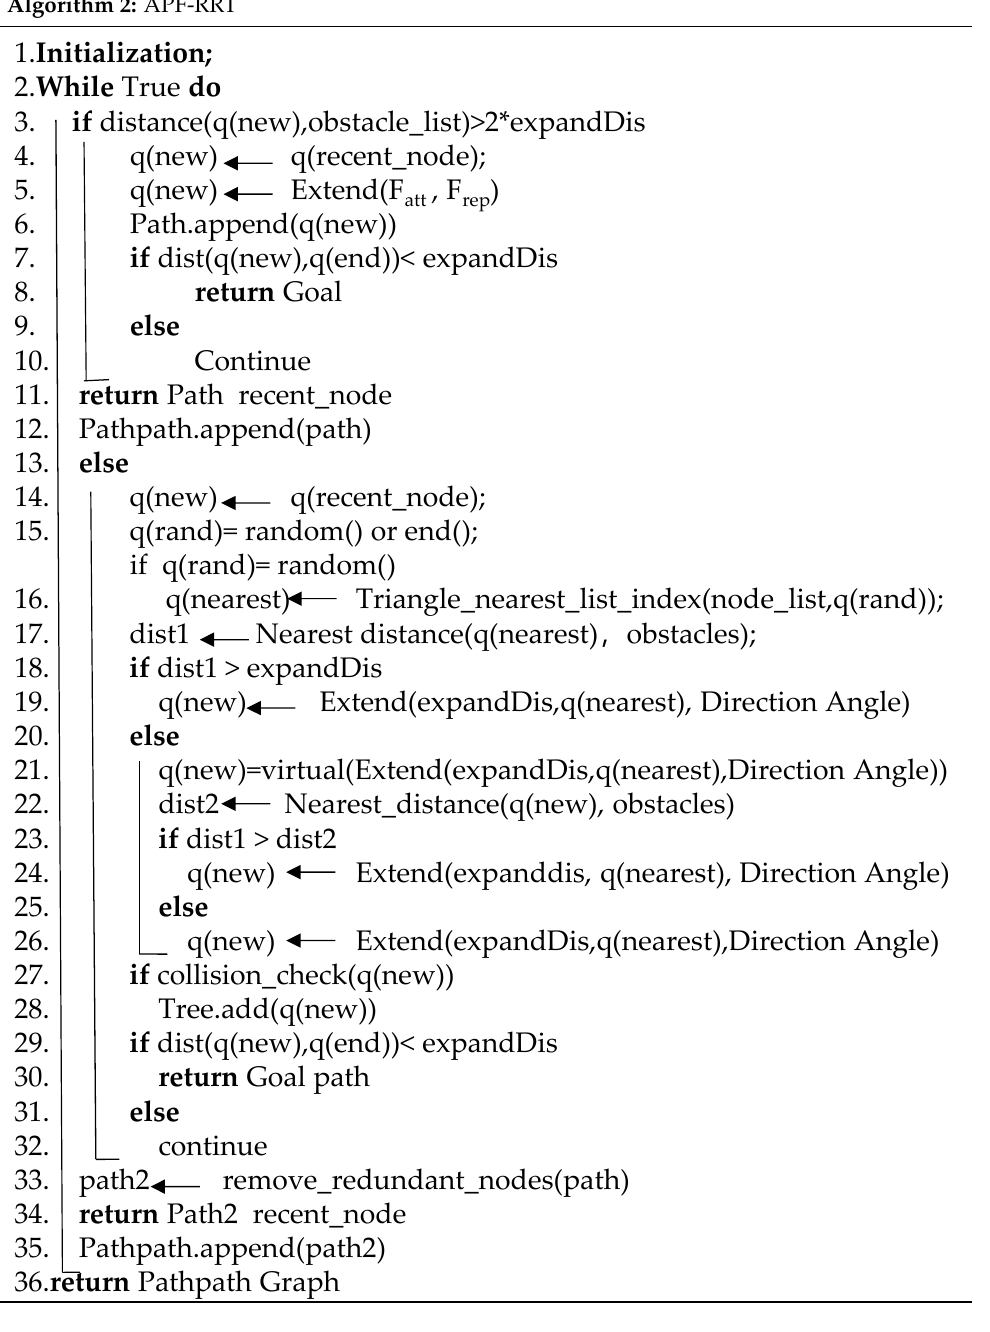
Algorithm 2: APF-RRT Algorithm 2 :